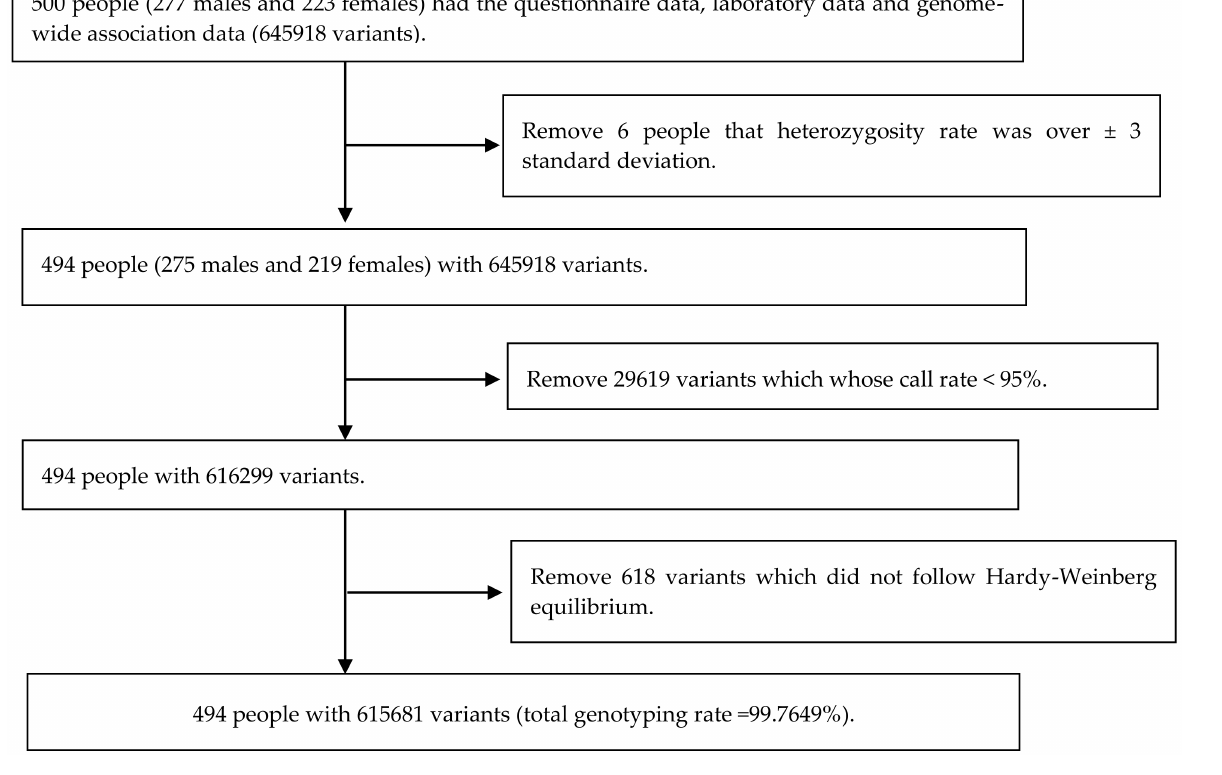
Figure 2. Flow chart for quality control of SNPs and selection of study